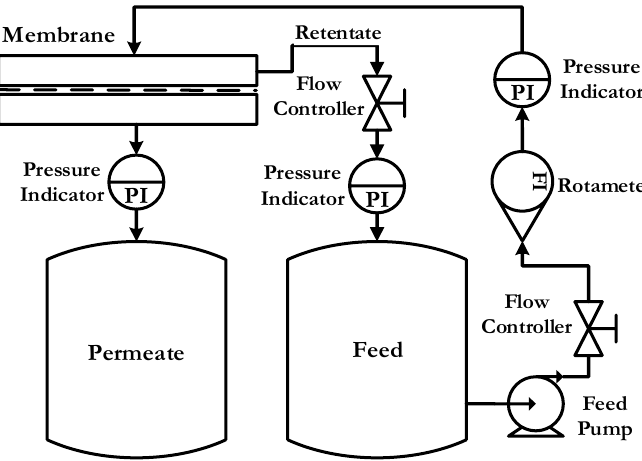
Figure 3. Process flow diagram of lab scale flat sheet membrane permeability test setup.